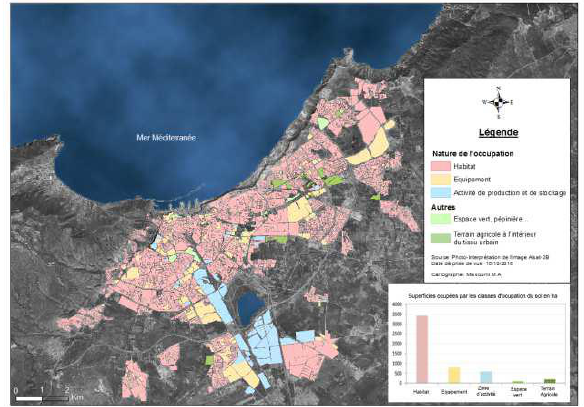
Figure 2 . Land cover map of the city of Oran.